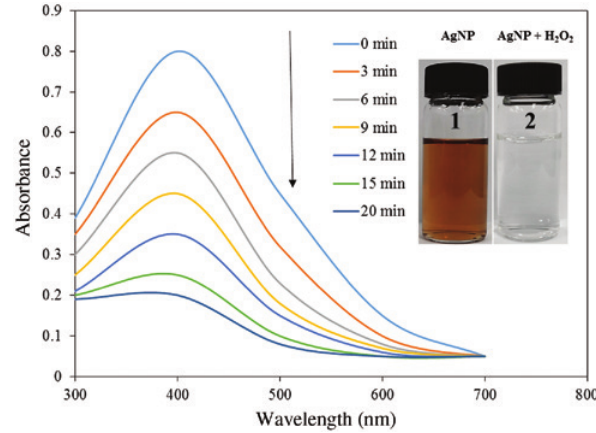
, 40 ° C, and 45 min) synthe- 3 O solution as a function of 2 2